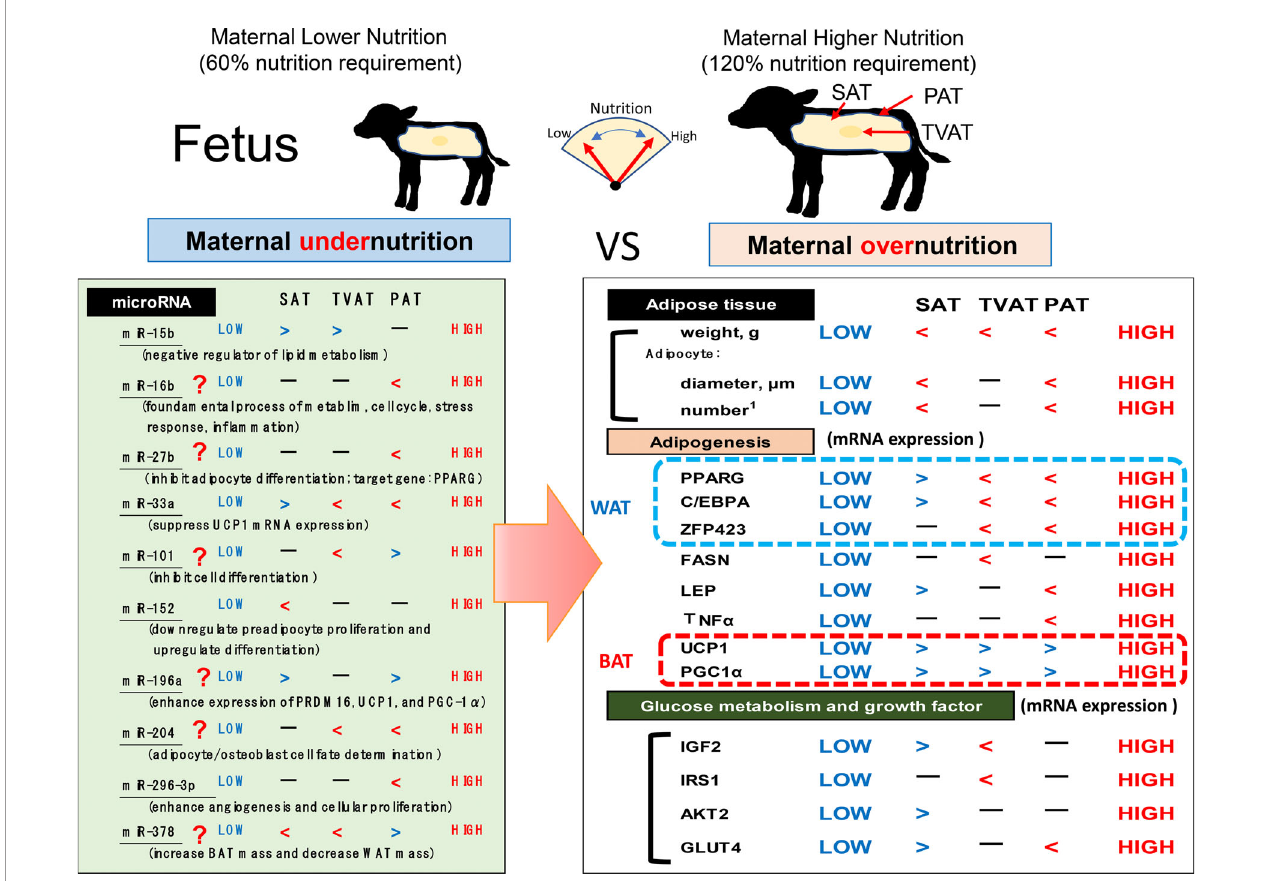
FIGURE 7 | Hypothetical scheme of the in fl uences of maternal under- or overnutrition on the associations between fetal SAT, TVAT, and PAT development in weight, histochemical properties, gene expression (related to adipogenesis, growth factors, and glucose metabolism), and miR expression. Inequality sign is based on p <